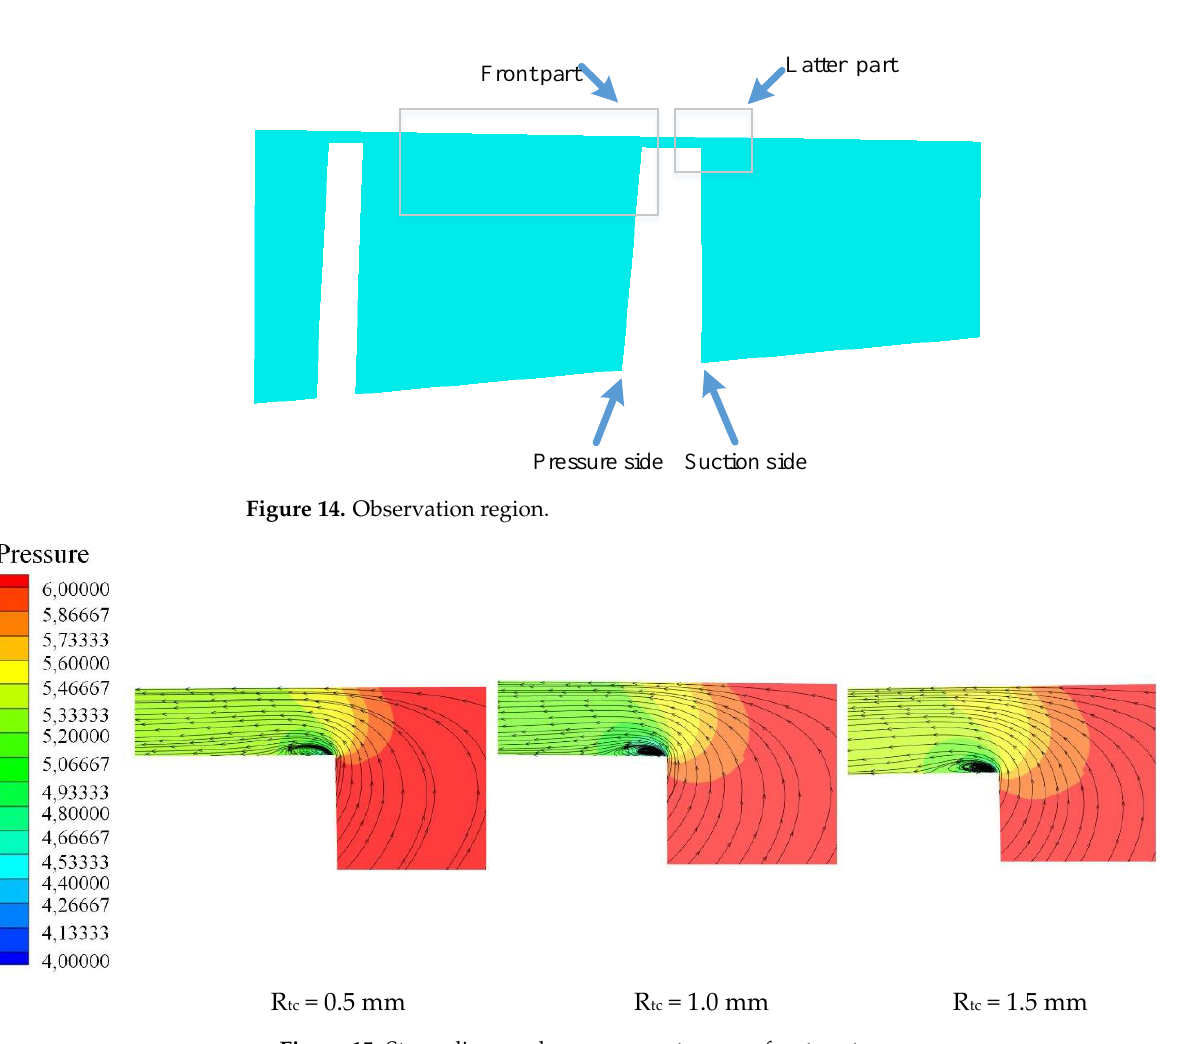
Figure 15. Streamlines and pressure contours on front part.